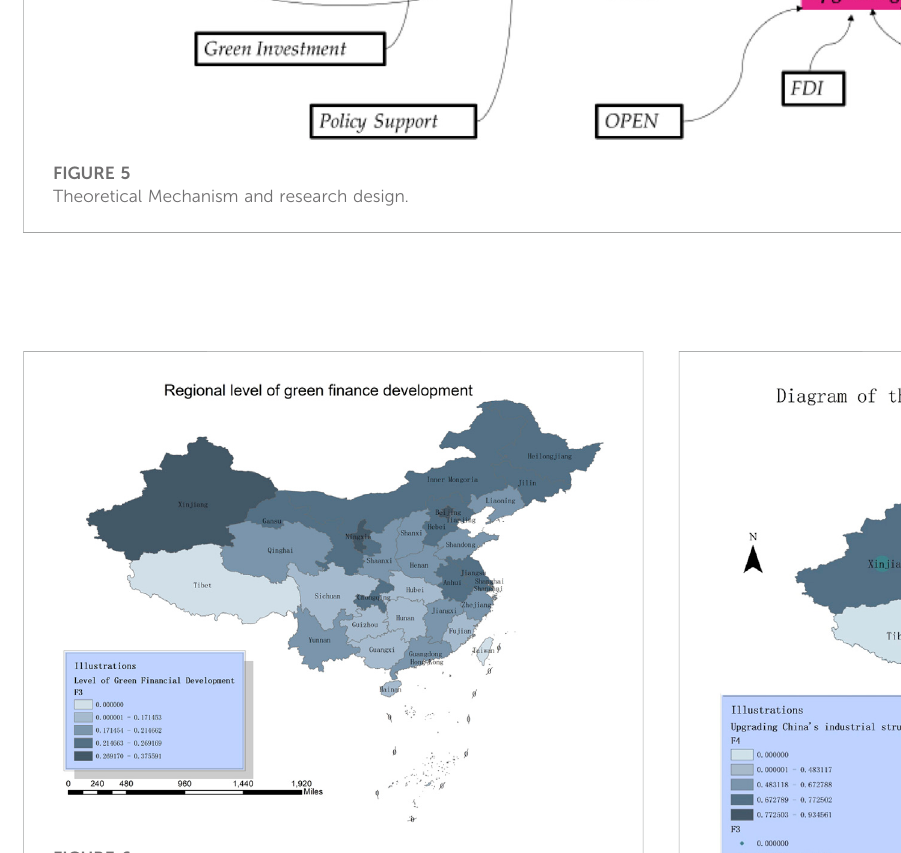
FIGURE 6 A geographical map of China ’ s level of green fi nance development.